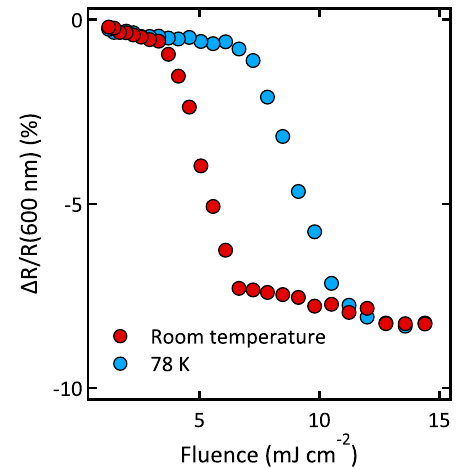
FIG. 6. Fluence dependence of the reflectivity change across the insulator-metal phase transition measured on a single crystal starting at an initial temperature of 78 K (blue circles) and 295 K (red circles), respectively. The difference in threshold can be explained by the thermal energy difference required to heat the sample from 78 K to 295